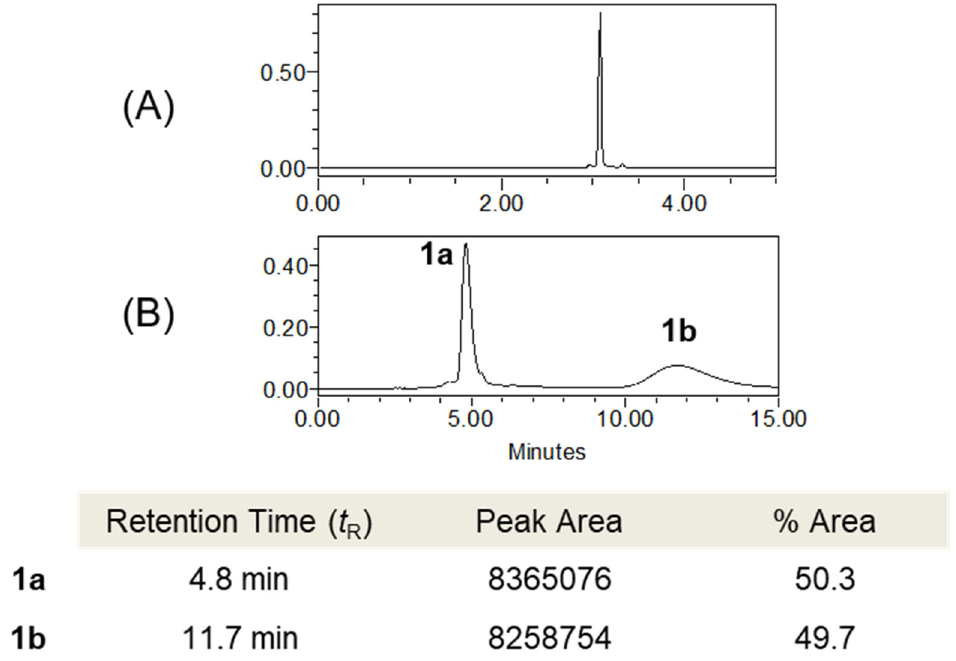
Figure 3. ( A ) UPLC chromatogram of compound 1 (stationary phase: ACQUITY UPLC BEH C 18 column (2.1 mm × 100 mm, 1.7 µ m); mobile phase: H 2 O–ACN, 95:5 to 50:50 in 5 min, 0.3 mL/min; UV 280 nm). ( B ) HPLC chromatogram of the enantiomeric mixture of compound 1 (stationary phase: Chiralpak IH column (4.6 mm × 250 mm, 5 µ m); mobile phase: n -hexane–EtOH–MeOH, 70:20:10 isocratic in 15 min, 1 mL/min; UV 280 nm).